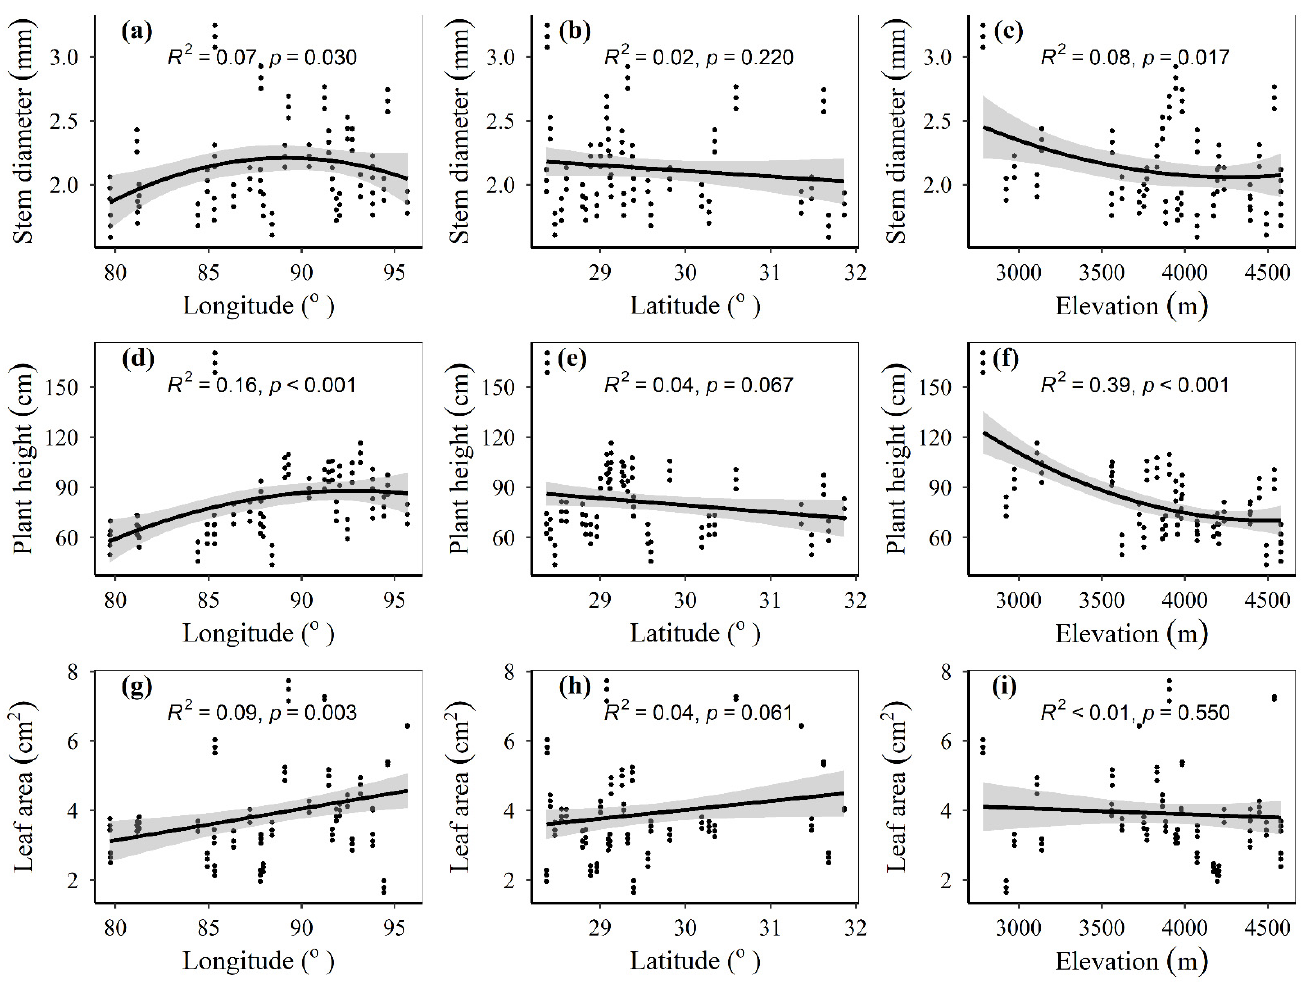
Figure A2. Relationships between ( a ) mean annual temperature (MAT) and longitude, ( b ) MAT and latitude, ( c ) MAT and elevation, ( d ) mean annual precipitation (MAP) and longitude, ( e ) MAP and latitude, ( f ) MAP and elevation, ( g ) annual temperature in 2020 (AT2020) and longitude, ( h ) AT2020 and latitude, ( i ) AT2020 and elevation, ( j ) annual precipitation in 2020 (AP2020) and longitude, ( k ) AP2020 and latitude, and ( l ) AP2020 and elevation.